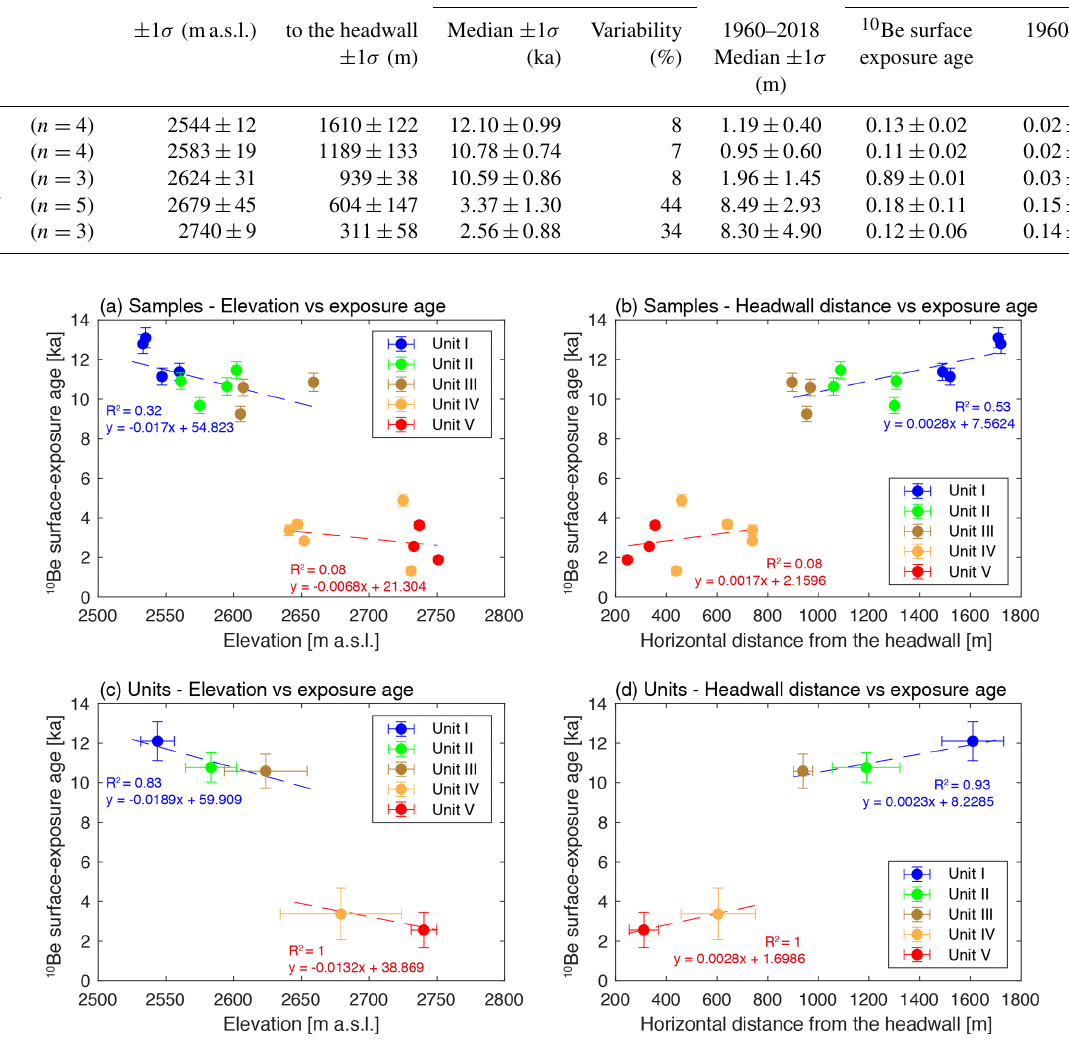
Figure 7. The 10 Be surface-exposure ages of individual samples (a, b) and units ( c, d , median values) plotted against elevation (a, c) and horizontal distance to the headwall (b, d) . The dashed red and blue lines represent the linear regressions for cluster 1 (units I, II, and III) and 2 (units IV and V),